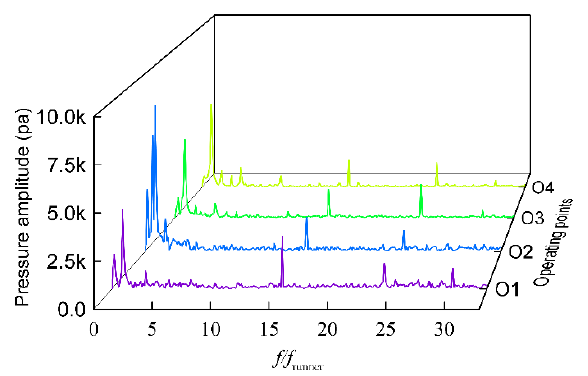
Figure 13. Spectral analysis of the pressure signals of R 1p in the runner under the four different operating conditions.